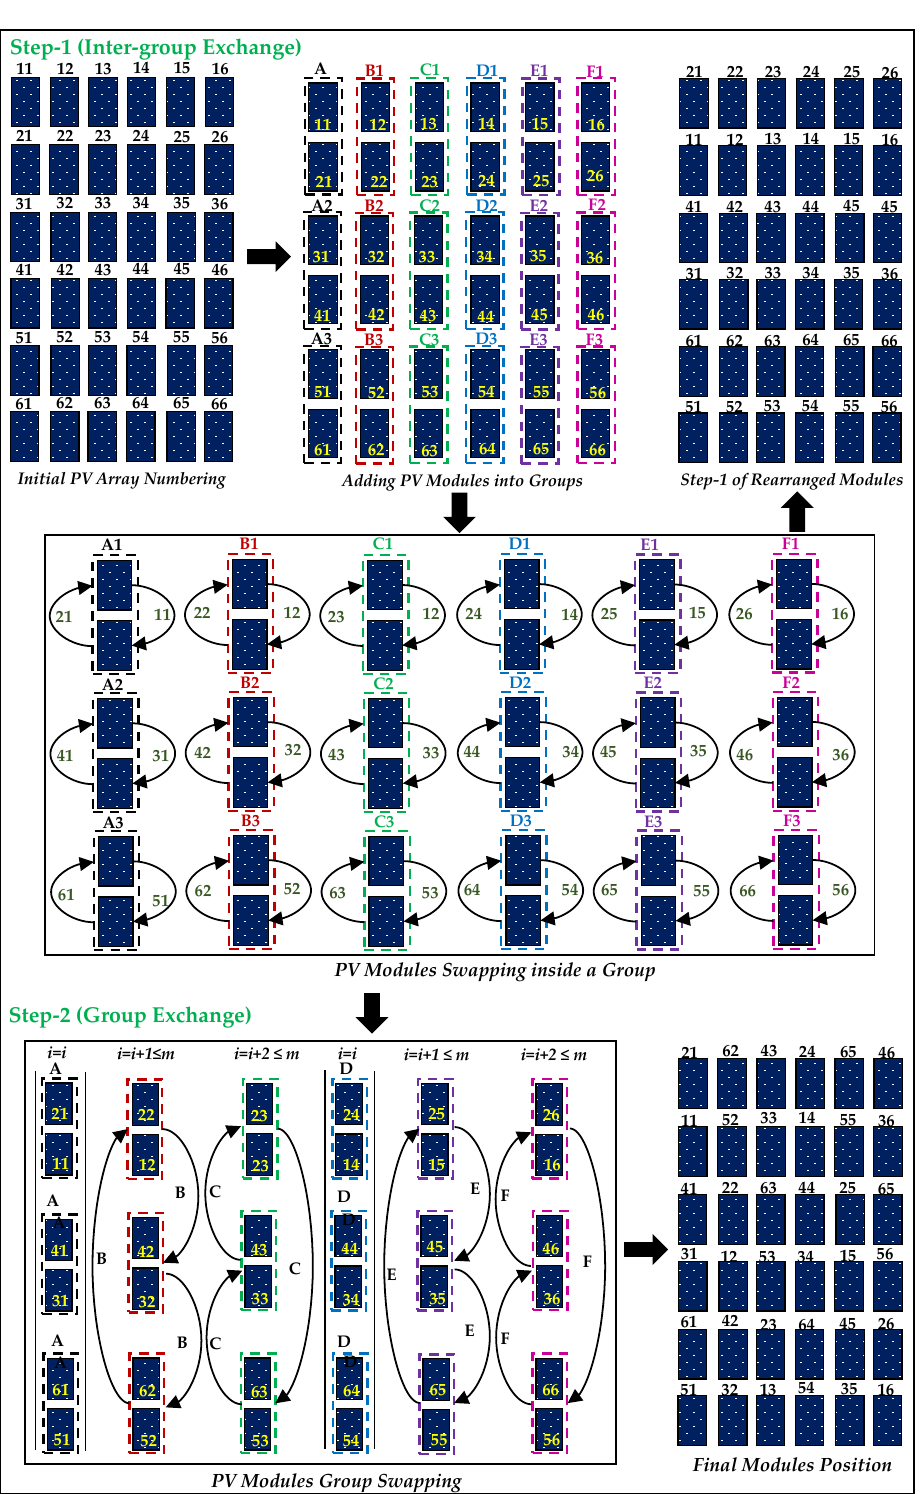
Figure 4. Graphical representation of the steps involved in the proposed two-step approach to module placement in the PV array. Step-1 (Inter-Group Exchange) : Initially, the array is divided into multiple groups